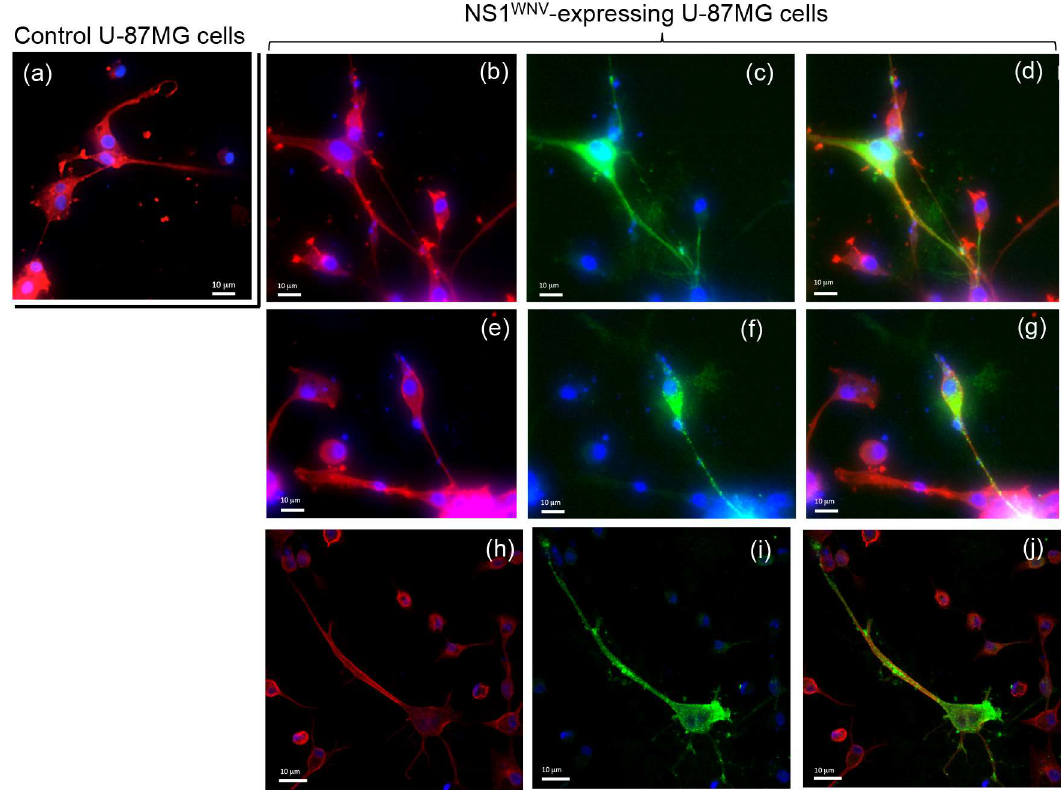
Figure 7. Actin network in recombinant NS1 WNV -expressing human glial cells U-87MG. U-MG87 cells were transfected with control empty plasmid pcDNA3.1 ( a ) or with pNS1 WNV-IS98 ( b – j ) and analyzed at 24 h pt by confocal fluorescence microscopy, using rhodamine–phalloidin for the visualization of actin filaments, and specific rabbit antibody for the immunolabeling of NS1 WNV . ( b , e , h ) Actin signal; ( c , f , i ) NS1 WNV signal; ( d , g , j ) merged signals. Nuclei were stained in blue using DAPI reagent. The panels presented in this figure show microscopic fields observed at different magnifications. Note the coexistence of actin and NS1 WNV signals in the cellular projections.